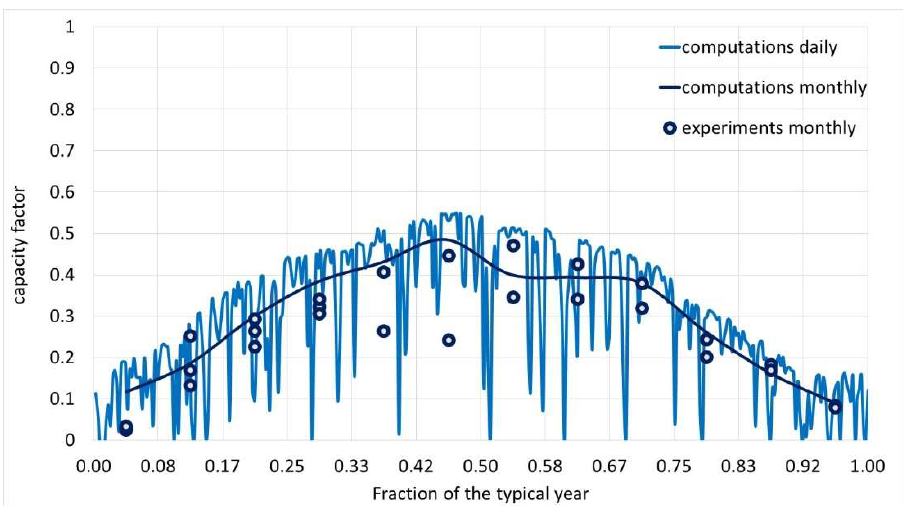
Figure 7. Mojave solar facility. Daily and monthly capacity factors from computations and monthly capacity factors from experiments. X is the fraction of the year. Y is the capacity factor. The experiments are the values measured since the completion of the plant (multiple entries per month).